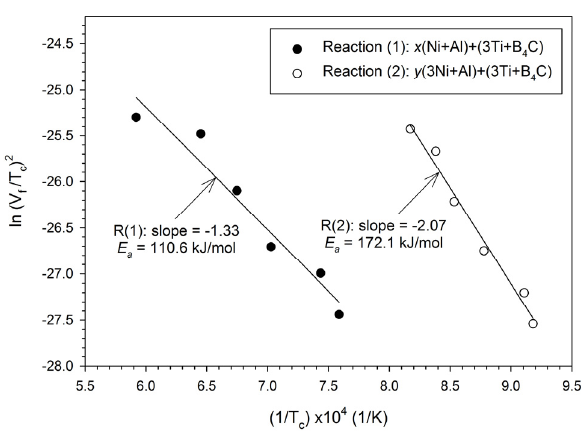
Figure 4. Linear correlation between combustion wave velocity and peak combustion temperature determination of activation energies ( E a ) of Reactions (1) and for determination of activation energies ( E a ) of Reactions (1) and (2).